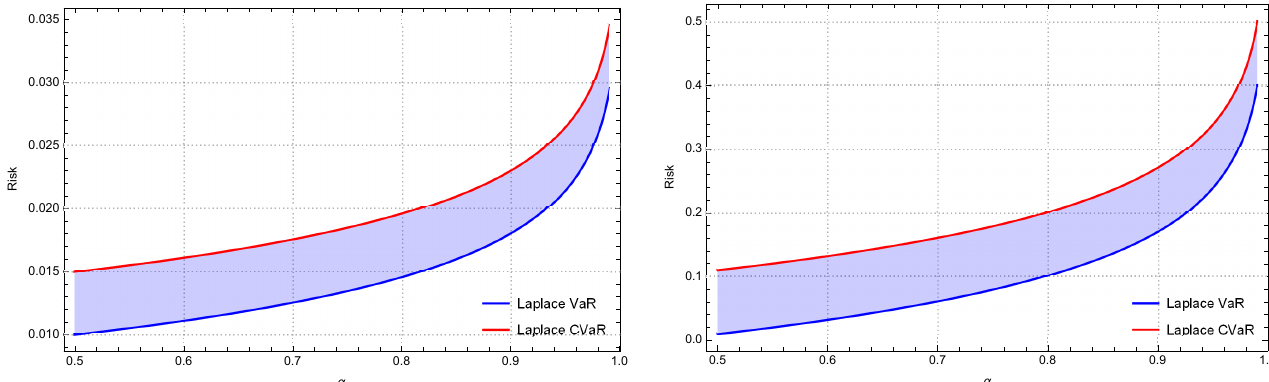
Figure 2. Laplace VaR and CVaR by varying the predetermined confidence level for µ = 0.01 and σ = 0.005 and σ = 0.1 on the left and right,